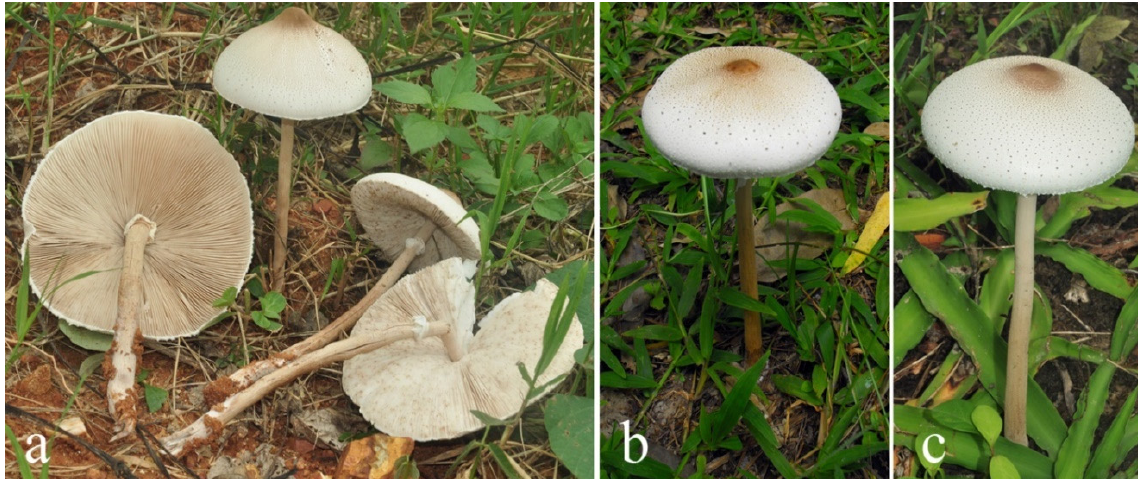
Figure 17. Fresh basidiomata of Macrolepiota dolichaula in situ. ( a ) MFLU 12-1816. ( b ) MFLU 12-1776. ( c ) HNL503204.